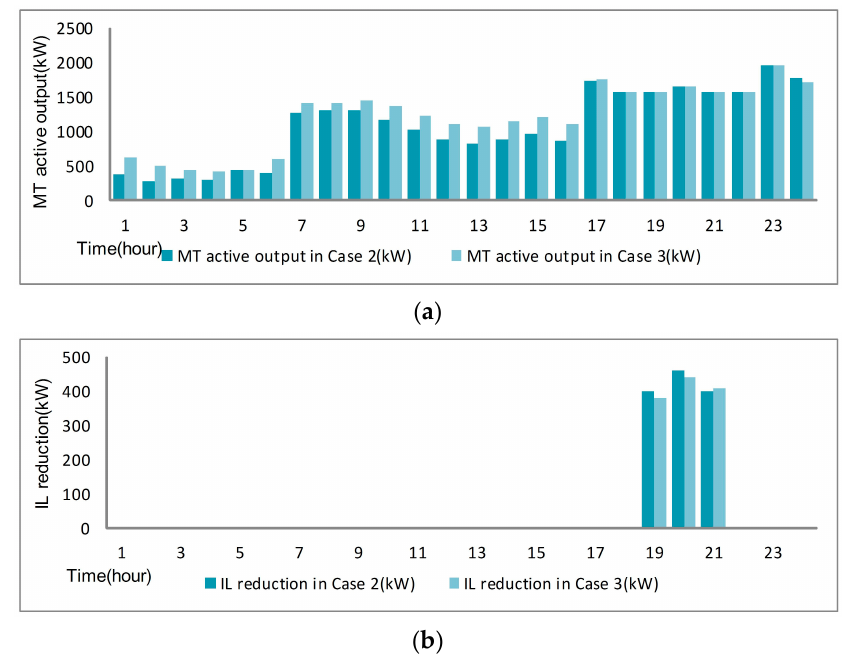
Figure 7. Comparisons of DER outputs in each hour between Case 2 and Case 3. ( a ) Comparison of